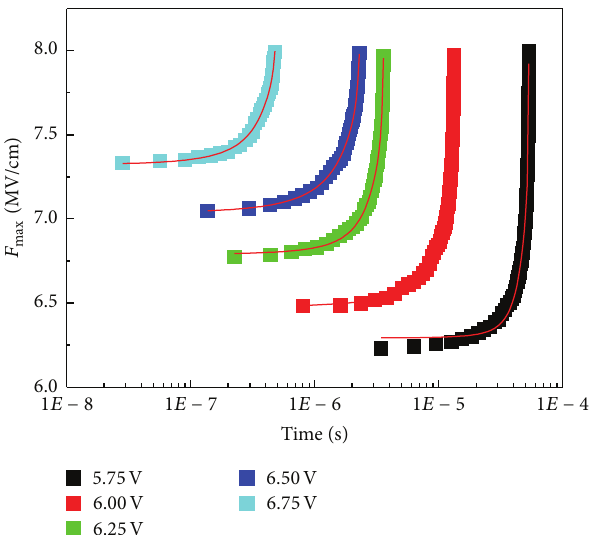
Figure7:Maximumelectricfieldcalculatedusingthefractalgrowth of the conductive filament for several operation voltages (symbols) and interpolating analytical functions given by the sum of two exponentials (continuous lines).